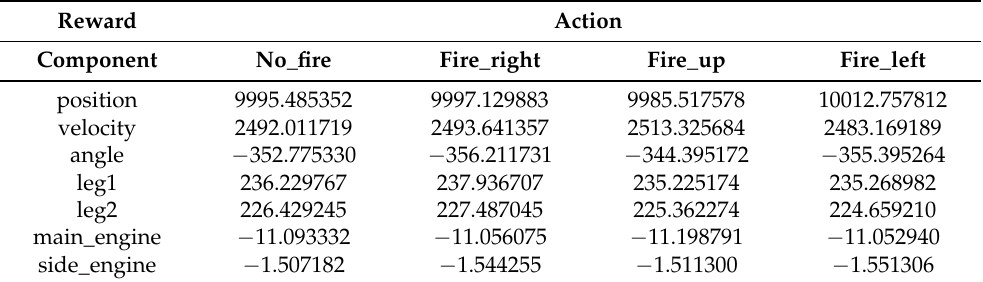
Table A7. Base values of the Lunarlander agent when reward prioritization is applied. Reward